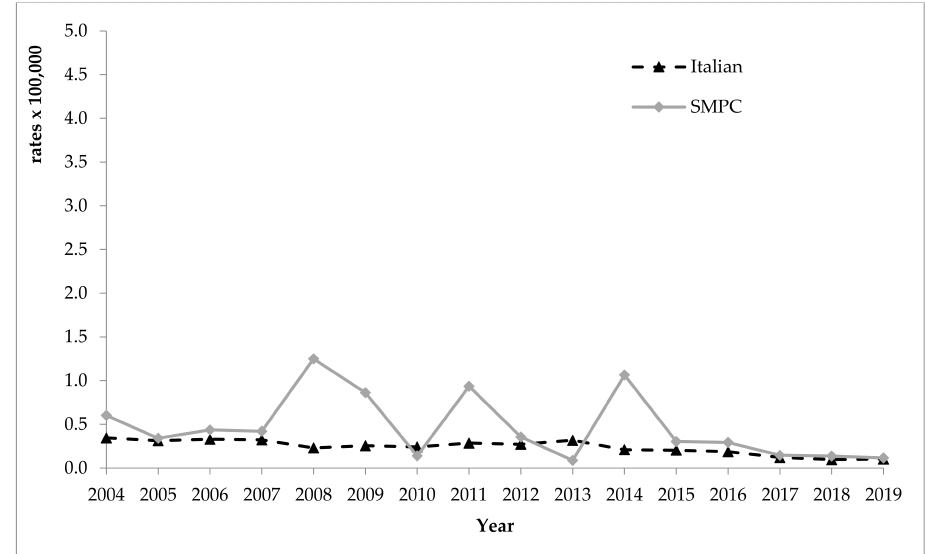
Figure 3. Incidence rates (standardised per 100,000) of viral acute hepatitis C in the foreign population from SMPC and among Italians, years 2004–2019. SMPC—Strong Migratory Pressure